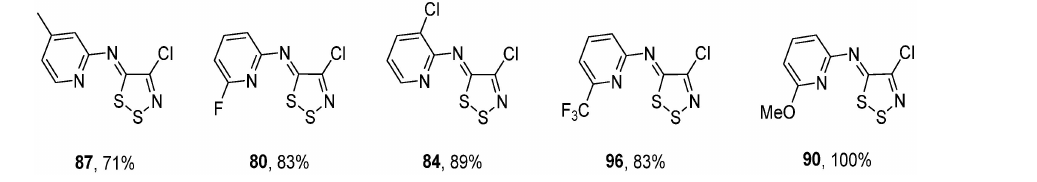
Figure 17. Leptosphaeria nodorum (wheat) preventive ≥ 70% efficacy at concentration of 1000 ppm.